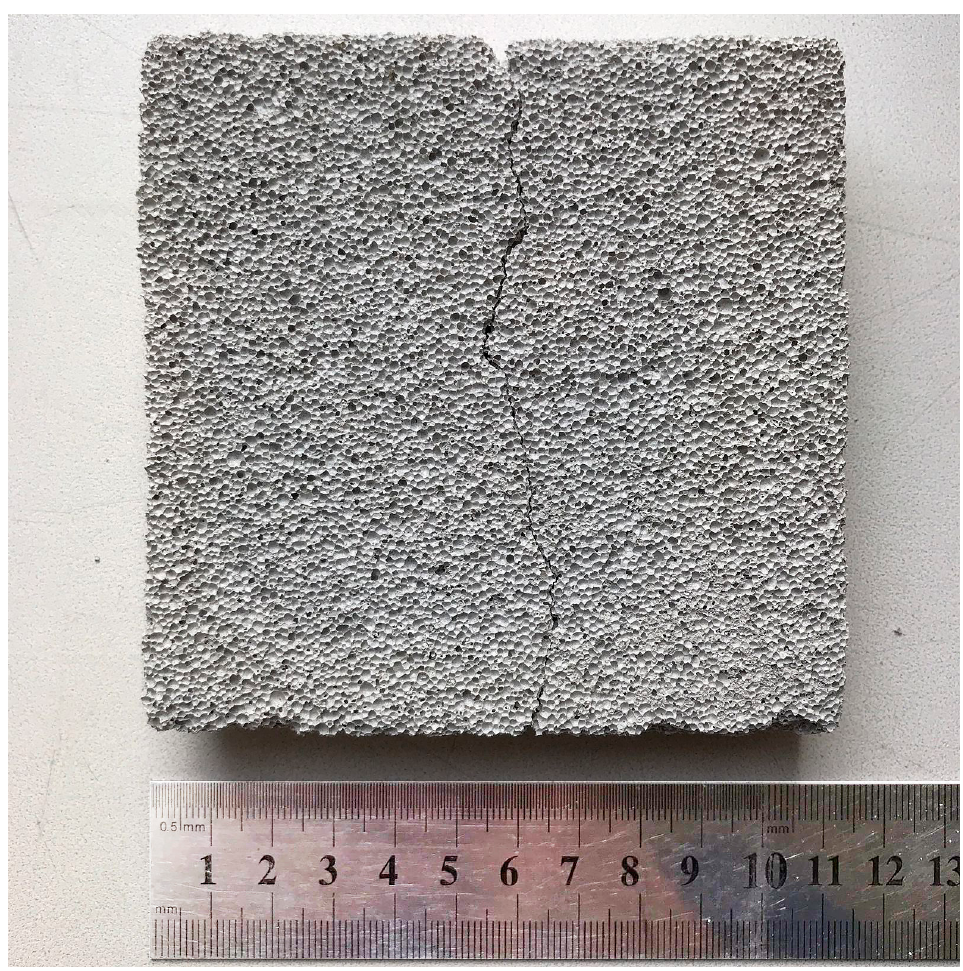
Figure 1. Crack on a sample of aerated concrete.